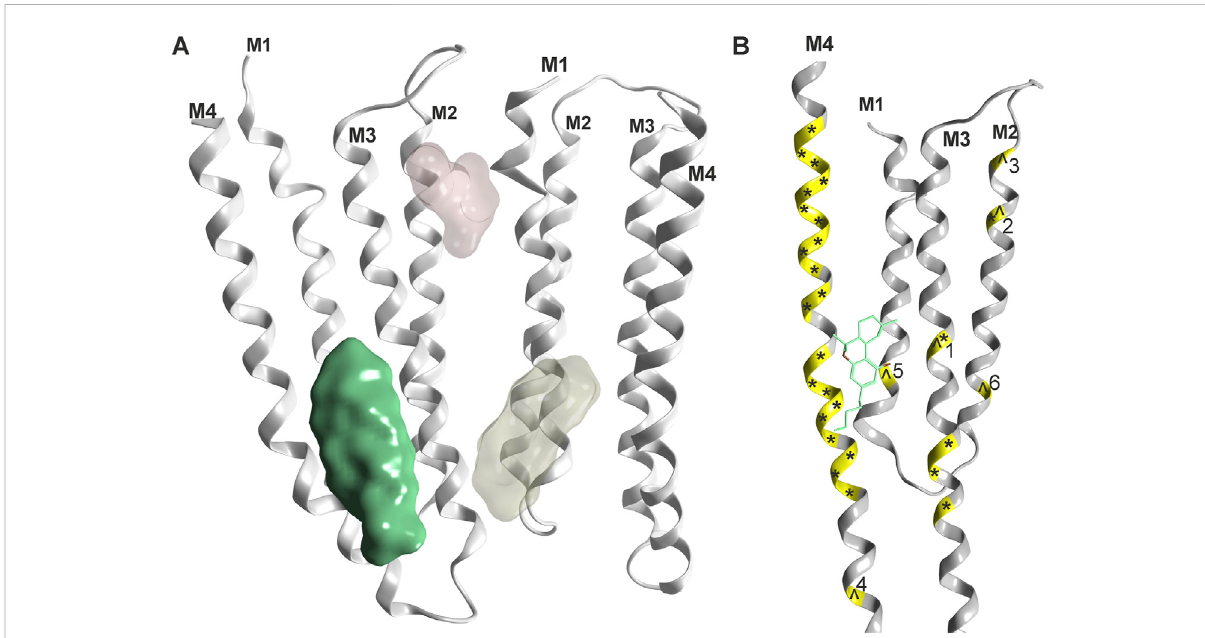
FIGURE 4 Phytocannabinoid sites on Cys-loop receptors: (A) Overview, one con fi rmed site (green, rendering of 7M6Q Kumar et al.) and two superposed candidate sites based on mutational evidence and computational docking (Koniuszewski et al., 2022, yellowish and light red). (B) Detailed rendering of 7M6Q with Δ 9-THC bound. Mutational sites as shown in Table 1 are color coded on the ribbon in yellow. Mutations in the glycine receptor are marked with an ^ and mutations in the GABAA receptor are marked with an *. Numbers refer to Table 1 for individual mutated